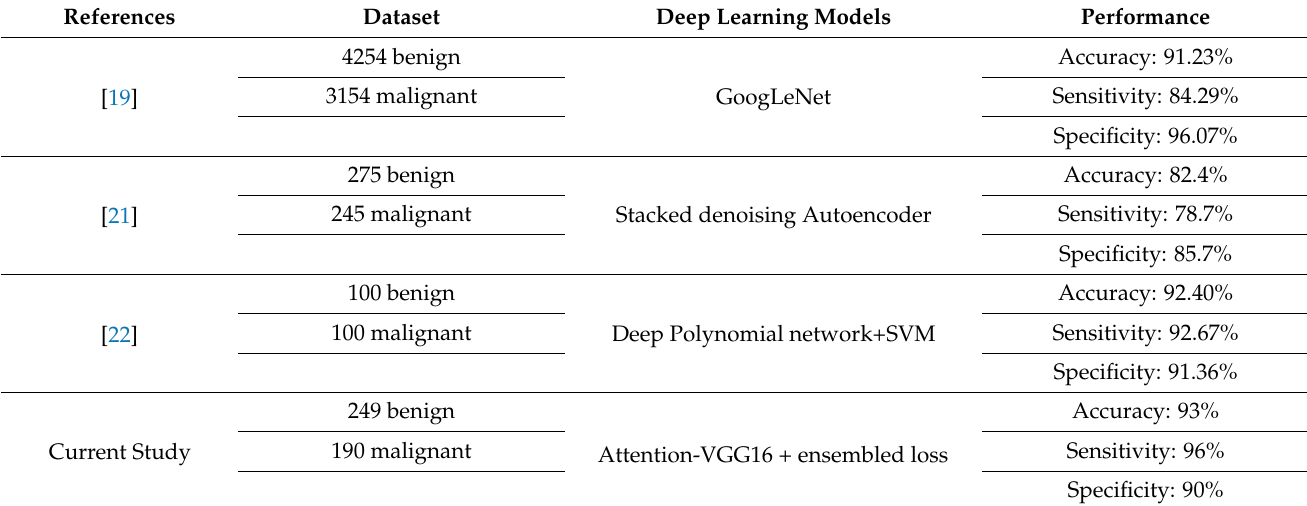
Table 2. The state of the art of deep learning models for breast ultrasound lesion